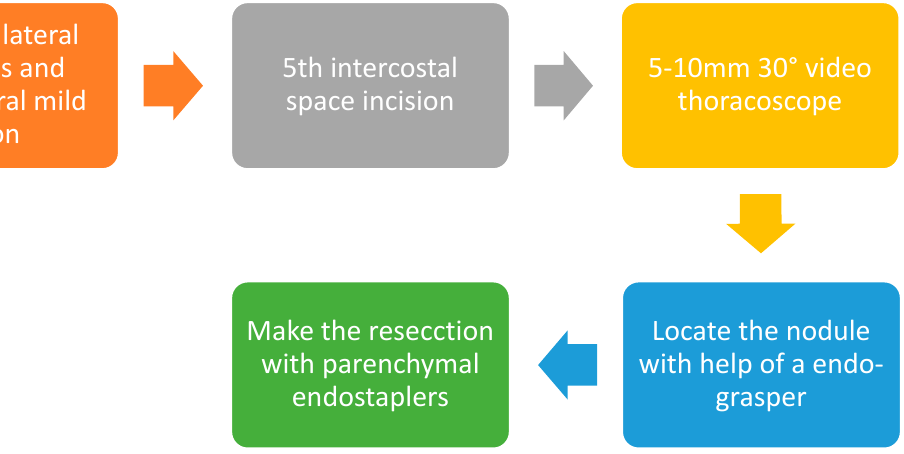
Figure 3. Uniportal VATS diagnostic wedge (step by step).